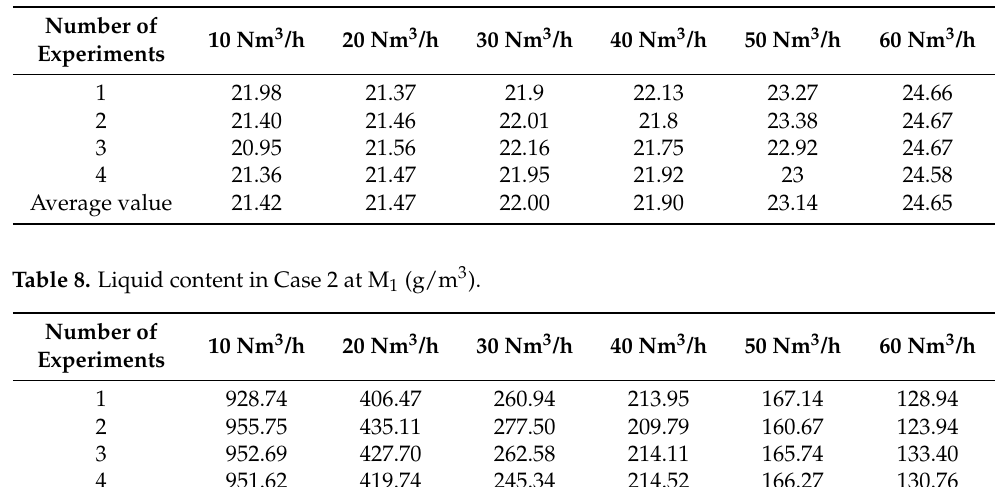
Table 7. Liquid particle size in Case 2 at M 1 ( µ m).